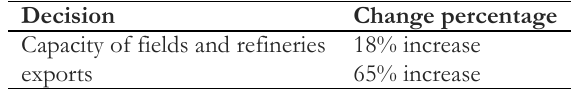
Table 3. Percentage of changes in various decisions based on the proposed model.